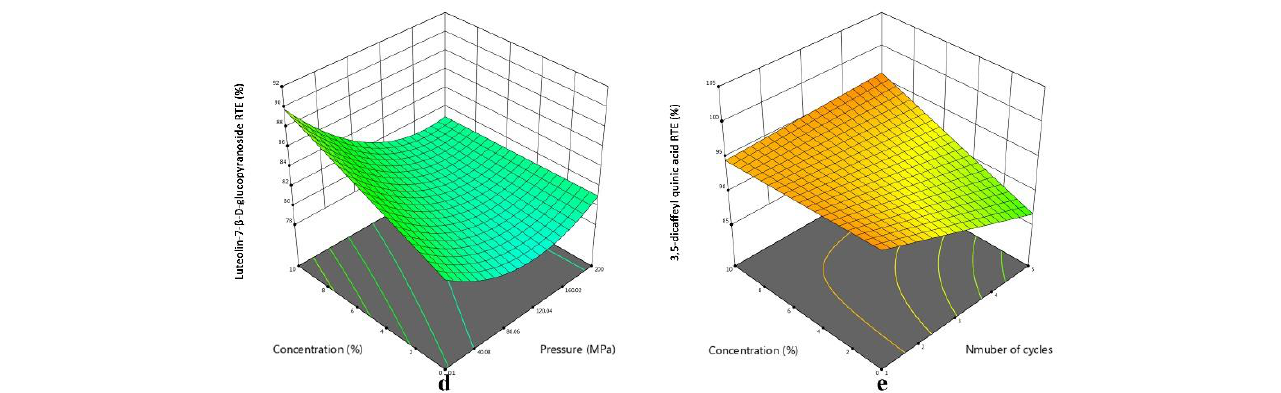
Figure 3. Three-dimensional surface plots of functional components RTE: ( a ) pressure – number of cycles on chlorogenic acid; ( b ) pressure – concentration on chlorogenic acid; ( c ) number of cycles – concentration on chlorogenic acid; ( d ) pressure – concentration on luteolin-7- β -D-glucopyranoside; ( e ) number of cycles – concentration on 3,5-dicaffeyl quinic acid.